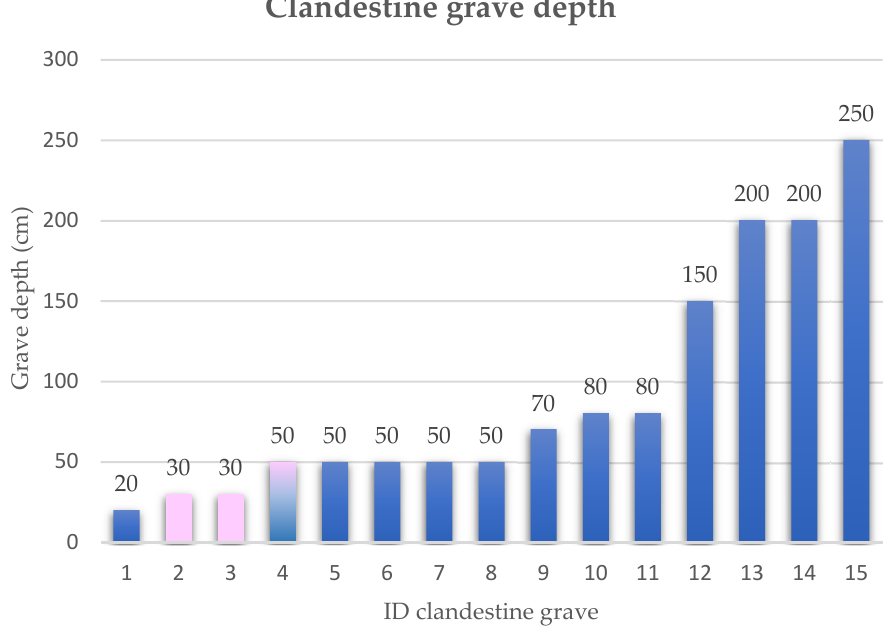
Figure 3. Histograms showing the clandestine grave depth of 15 graves dug from 1924 to 2022 [3–44,49]. Legend—Blue color: grave dug by men; pink color: grave dug by women; pink to blue color: grave dug by women and men together.